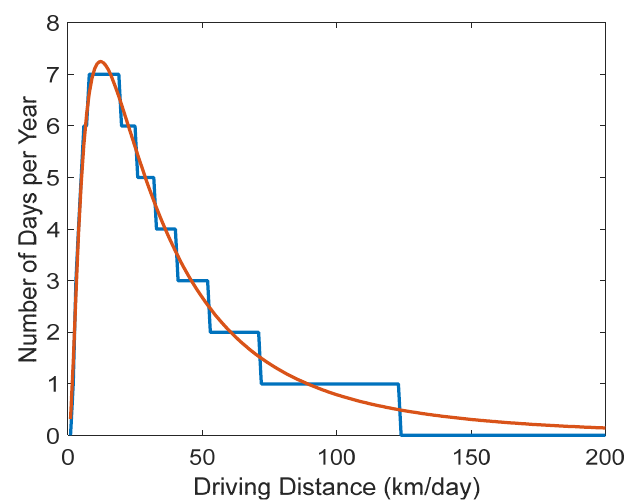
Figure 2. The distribution of daily driving distance through the year.